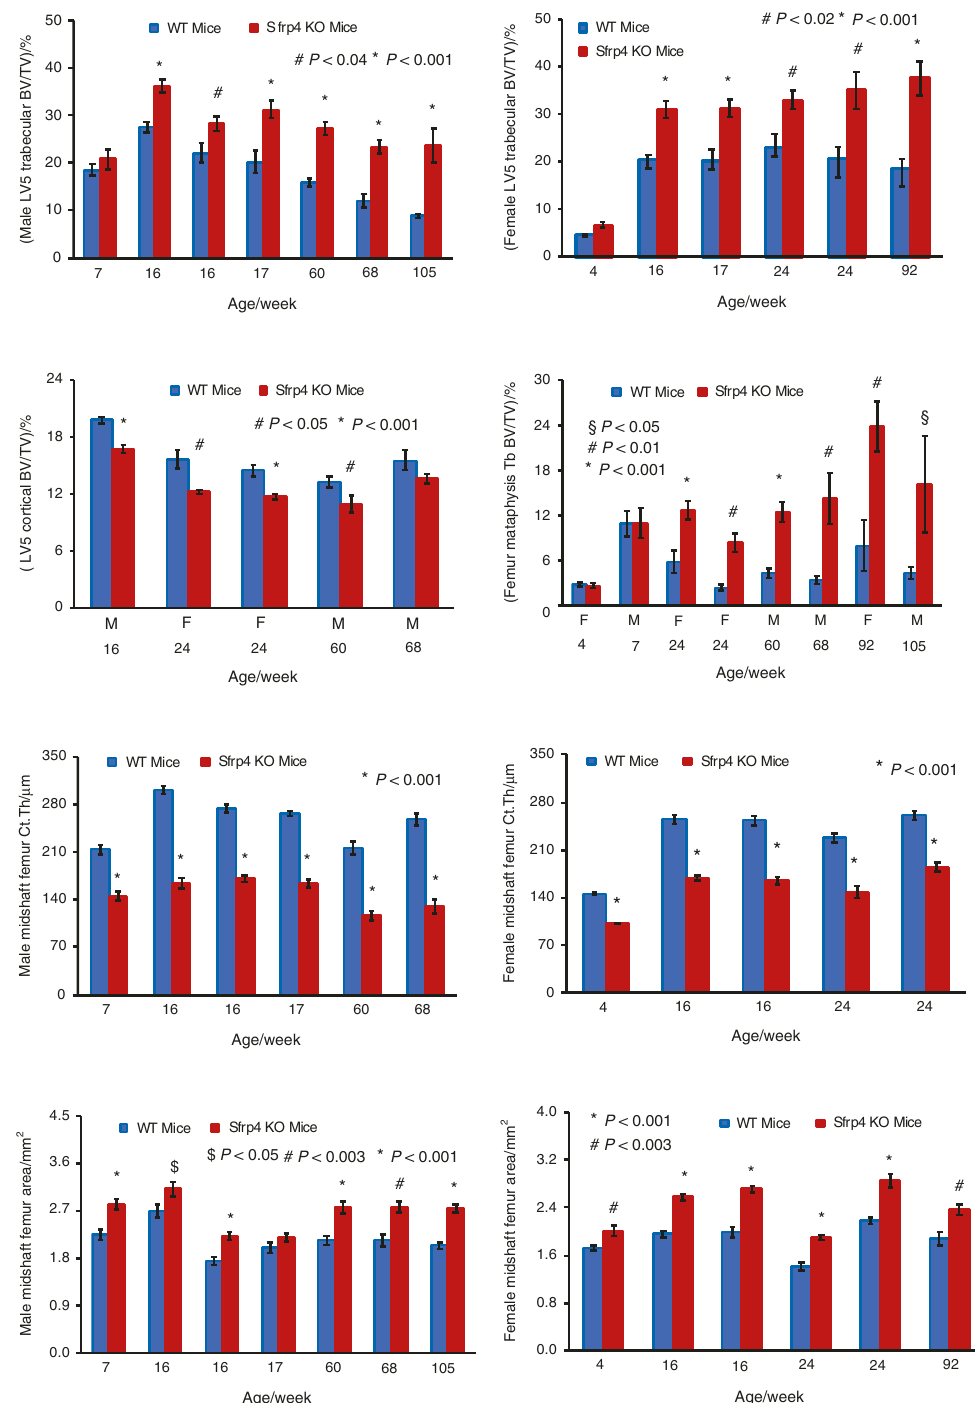
Fig. 1 Age-dependence of skeletal phenotypes in Sfrp4 KO mice. All data are means ± SEMs for 7 to 14 mice. Statistical analyses by student ’ s t - mutations in ANKH (craniometaphyseal dysplasia, 29 COL10A1 (Schmid metaphyseal dysplasia, 30,31 FLNA (frontometaphyseal dysplasia, 32 GBA (Gaucher ’ s disease, 33 LRRK1 (osteosclerotic metaphyseal dysplasia, 34 PTH1R (Jansen ’ s metaphyseal chondro- dysplasia, 35 and CLCN7, 36,37 PLEKHM1, 38 and SNX10 39 each